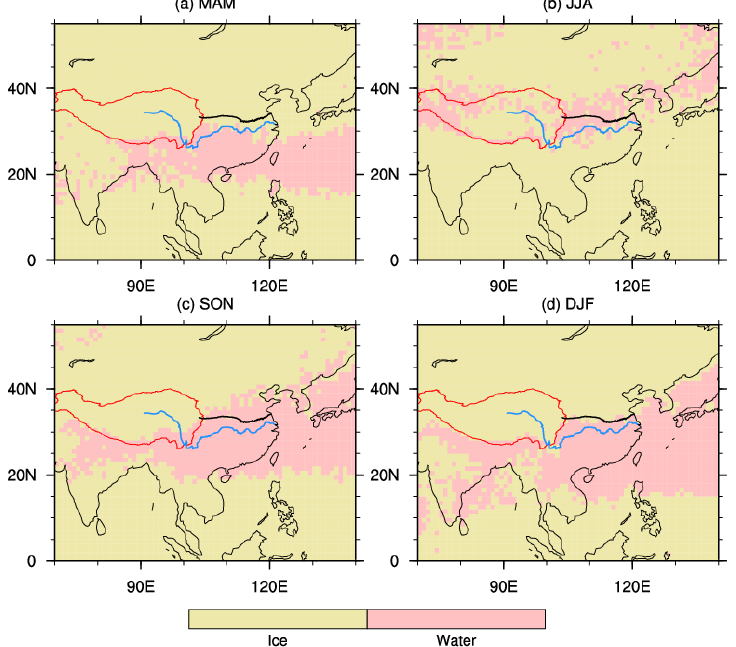
Figure 8. Horizontal distribution of cloud phase in various seasons: ( a ) spring (MAM), ( b ) summer (JJA), ( c ) autumn (SON), and ( d ) winter (DJF). The red solid line is the Qinghai–Tibet Plateau, the blue solid line is the Yangtze River, and the black thick solid line is the Qinling Mountain and Huaihe river.